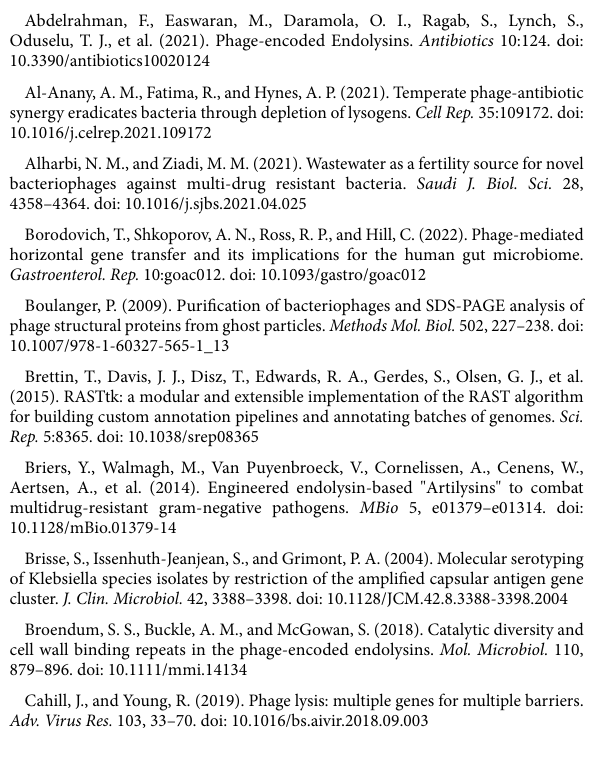
SUPPLEMENTARY FIGURE S4 Phylogenetic tree of endolysin amino acid sequences of 70 Klebsiella phages. Phylogenetic tree was constructed using putative endolysin sequences of KP1 (KP1.peg.110), KP12 (KP12.peg.319), and 68 amino acid sequences annotated as endolysin in NCBI-deposited Klebsiella phages. All labels except KP1 (KP1.peg.110, highlighted in red) and KP12 (KP12.peg.319, highlighted in blue), contain NCBI protein ID (YP_#), its product and its origin phage. Multiple sequence alignment and phylogenetic analysis were conducted with ClustalW alignment with maximum likelihood clustering algorithm with 100 iterations. SUPPLEMENTARY FIGURE S5 Structural prediction of the remaining putative endolysin sequences of KP1 and KP12. (A) AlphaFold models generated for KP1.peg.142, KP12. peg.198 and KP12.peg.279. Protein surface structure of the first pTM model (model_1) (top left), and its corresponding 2D plot showing the score for amino acid at each position (top right) are color-coded according to its pLDDT. PAE heatmaps of five models and their pTM scores illustrate the predicted error between all pairs of residues. The lower value (darker green) indicates a higher confidence in the prediction. SUPPLEMENTARY FIGURE S6 Structure prediction of putative tail lysozyme subunit in KP1 (KP1.peg.142) and spanin in KP12 (KP12.peg.278). The structures of KP1.peg.142 (A) and KP12.peg.278 (B) were predicted using AlphaFold. Protein surface structure is color-coded according to the pLDDT scores of its first pTM model (model_1). SUPPLEMENTARY FIGURE S7 Validation of lytic capacity of putative endolysins in KP1 and KP12. Overexpression and purification of the putative endolysin in KP1 (A) and KP12 (B) . The information for each lane is described in the figures. (C) Spot tests of purified endolysins in K. pneumoniae lawn. Each row indicates spot test results from biological triplicates of purified endolysin in KP1 (upper row), KP12 (middle row), and blank buffer (lower row),